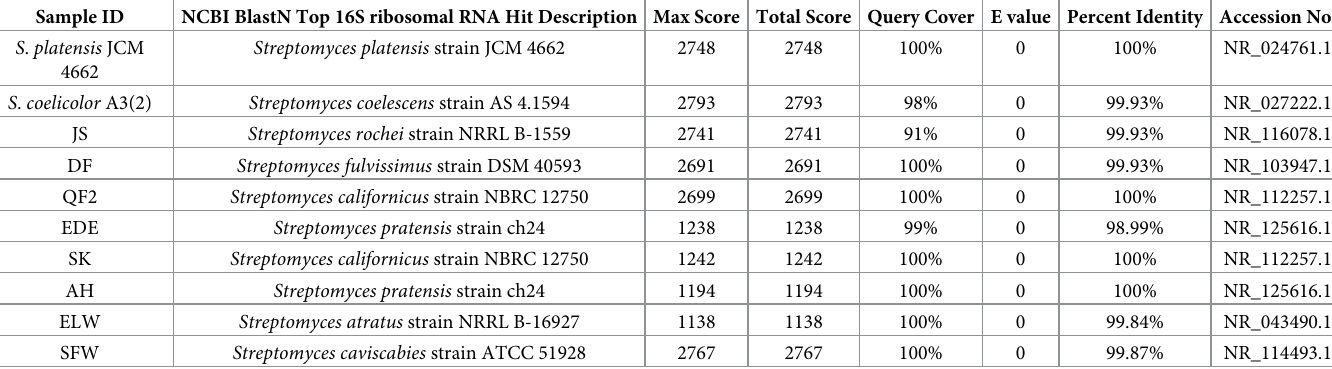
Table 1. Top NCBI BlastN hits of the 16S rRNA gene sequences. Sample